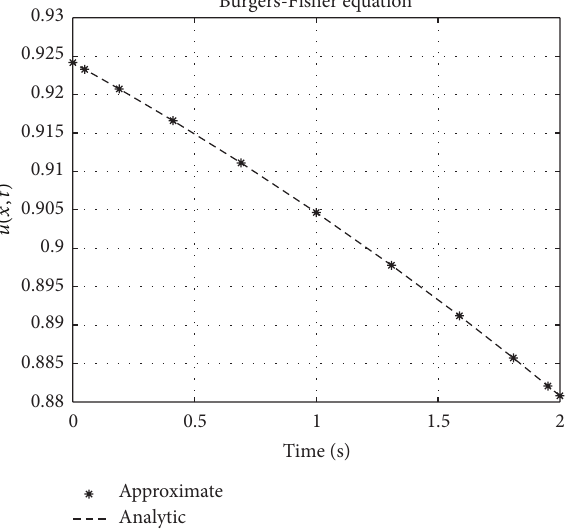
values of 𝑡 = 2 for different collocation points, 𝑁 𝑡 , in the 𝑡